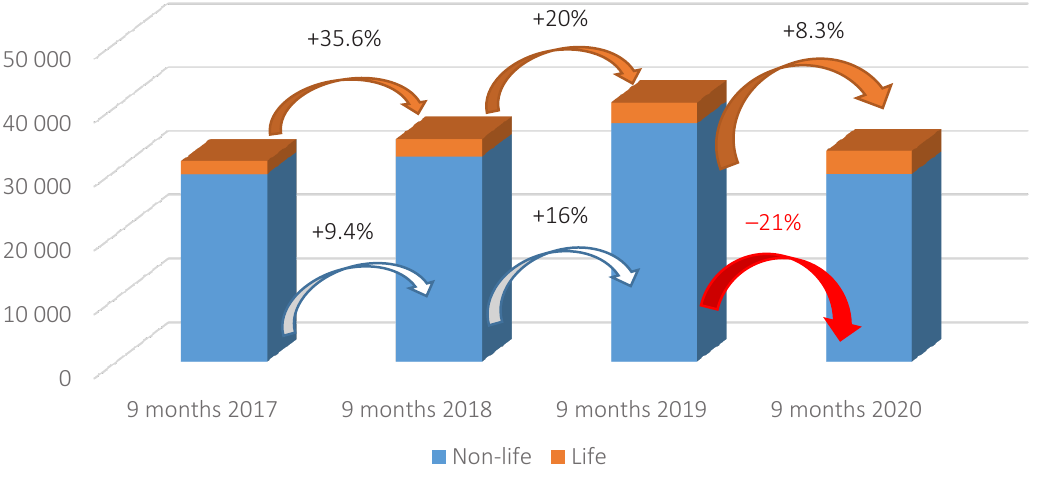
Figure 3. Dynamics of gross insurance